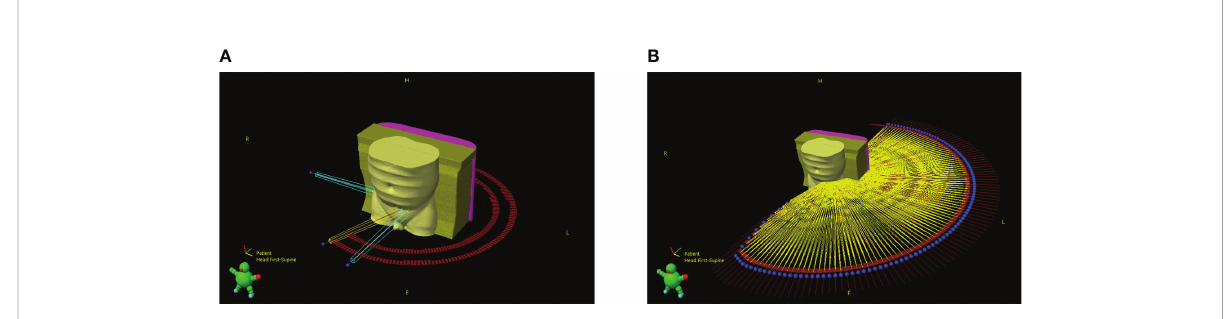
FIGURE 2 3D render of patient and beam geometry (A) before and (B) after the splitting process. Blue represents setup beams, yellow treatment beams, red marks are used to outline control point positions and the blue spheres represent the starting point of a